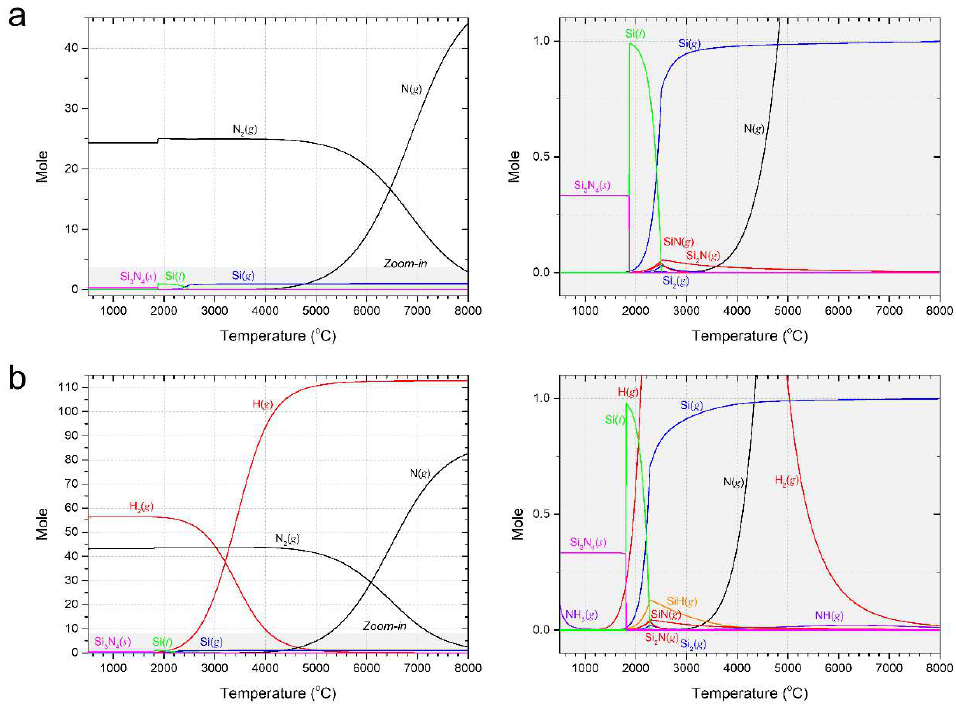
Figure 8. Chemical composition at the thermodynamic equilibrium ( a ) Si-N 2 system and ( b ) Si-N 2 - NH 3 system. An enlarged view of the graph (y-axis: − 0.1–1.1) is presented on the right side of each figure.